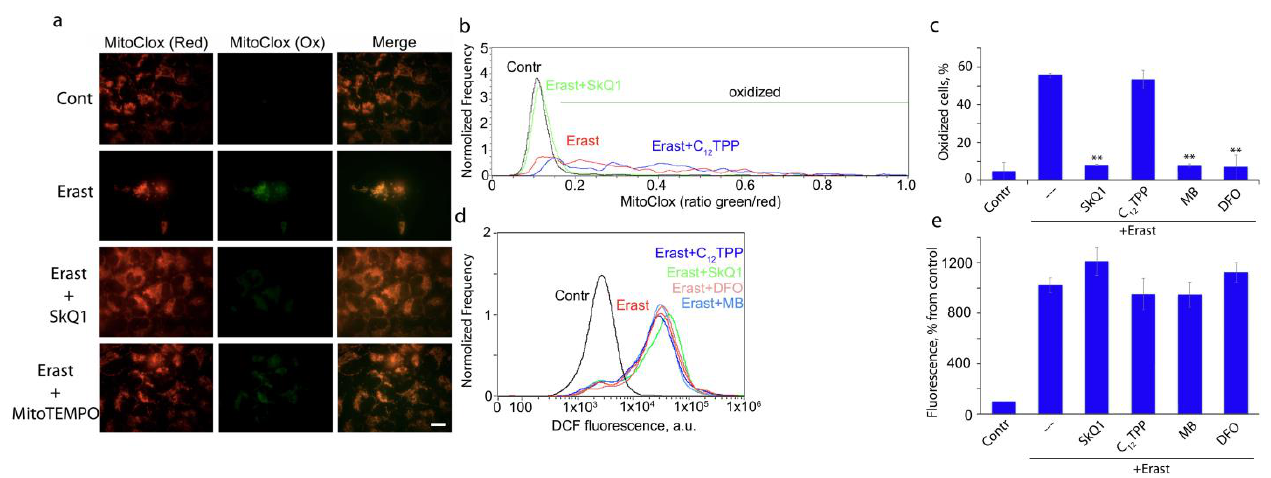
Figure 3. Peroxidation of mitochondrial lipids induced by erastin in MRC5-SV40 cells. Cells were treated with erastin (Erast, 10 μM) for 17 h. Peroxidation of mitochondrial lipids was measured with MitoCLox as described in Methods. ( a ) Fluorescent microscopy of the cells stained with MitoCLox in two channels (green and red). SkQ1 (100 nM) and MitoTEMPO (10μM) were added together with erastin. Bar,15 μm . ( b,c ) Results of MitoCLox oxidation analysis using flow cytometry. Green and red fluorescence were measured simultaneously, and an increase in the green/red ratio indicates oxidation of MitoCLox. Cell fractions with oxidized MitoCLox calculated as shown in (b) were measured in three independent experiments ( c ). MB (250 nM), DFO (100 μM), SkQ1 (100 nM), and C 12 TPP (100 nM) were added together with erastin for 17 h. ( d,e ) Results of DCFH2DA oxidation analysis using flow cytometry. SkQ1, C 12 TPP, DFO, and MB were added as in ( b,c ) together with erastin for 4 h. Median fluorescence of DCF was measured in three independent experiments. The fluorescence of nontreated cells (Contr) was taken as 100%( e ). **- p < 0.001